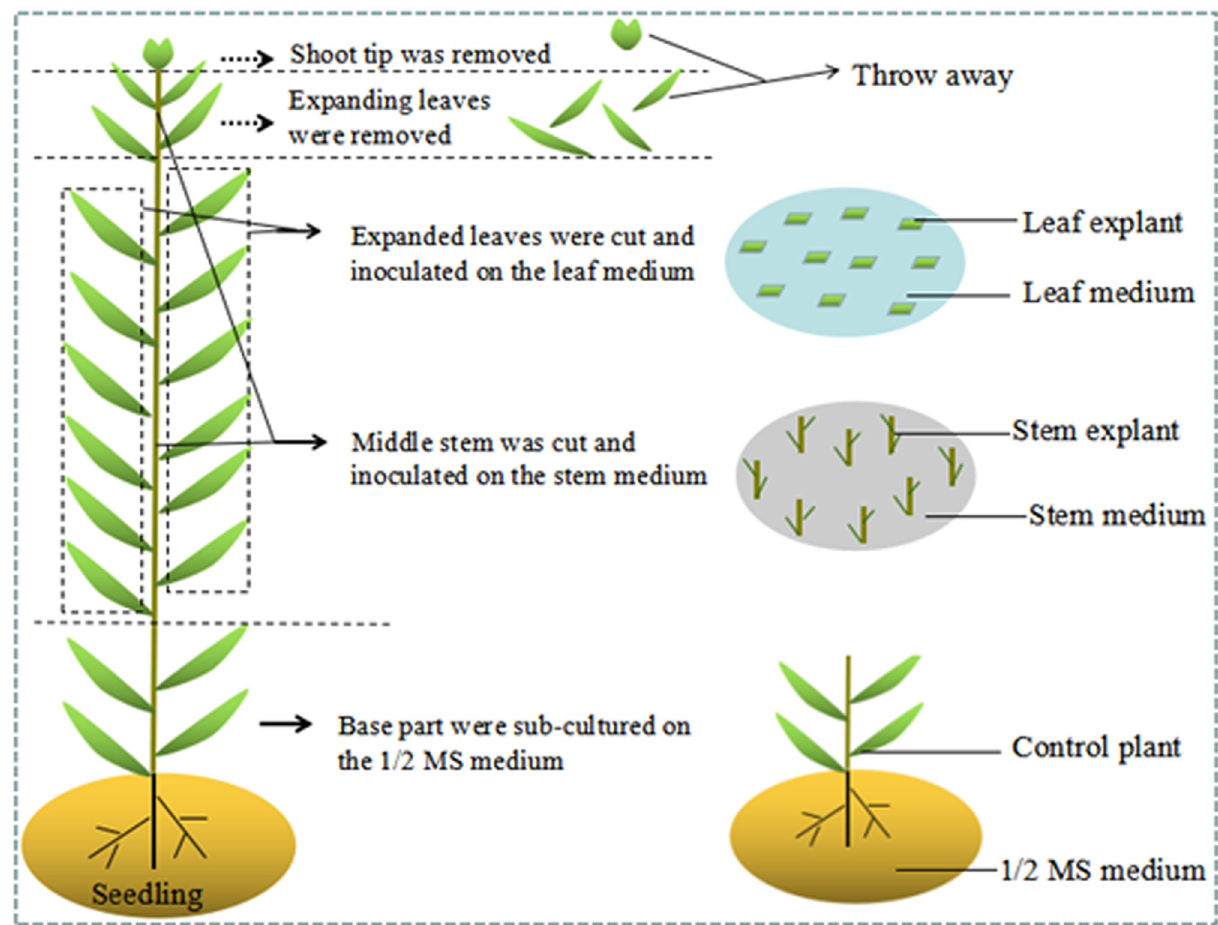
Fig 1. Process used to obtain the leaf and stem explants of L . ruthenicum .